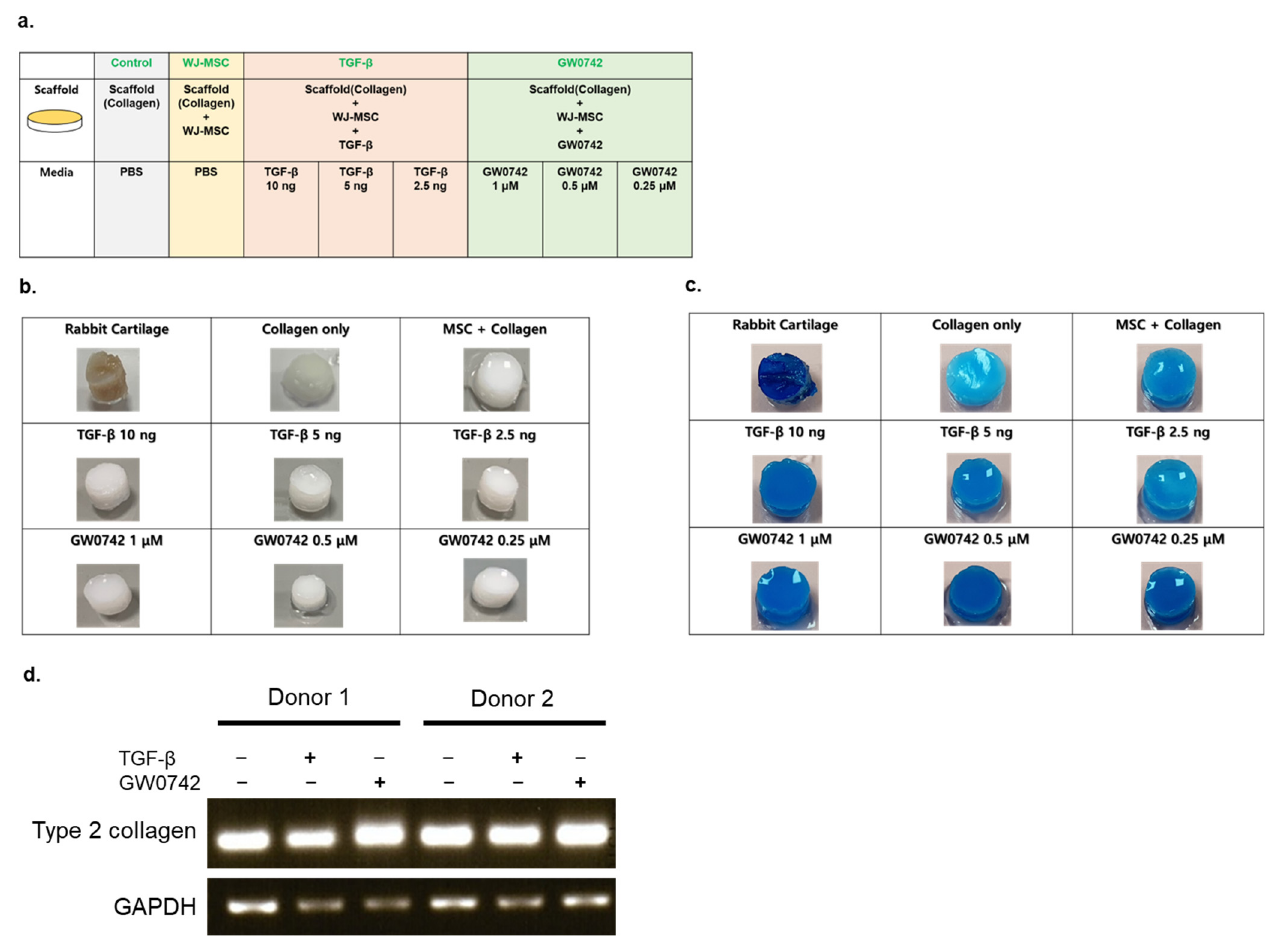
Figure 2. Ex vitro evaluation of chondrogenic differentiation capacity. ( a ) Illustrative scheme de- scribing the experimental design; ( b ) macroscopic observation of collagen-based scaffolds seeded with WJ-MSCs with the presence or absence of TGF- β or GW0742; ( c ) alcian blue staining of the scaffolds cultured with chondrogenic differentiation medium for 28 days; ( d ) reverse-transcription PCR analysis of type II collagen expression from MSCs derived from 2 different donors in the scaf- fold presence or absence of chondrogenesis inducers (10 ng/mL of TGF- β or 1 uM/mL of GW0742).